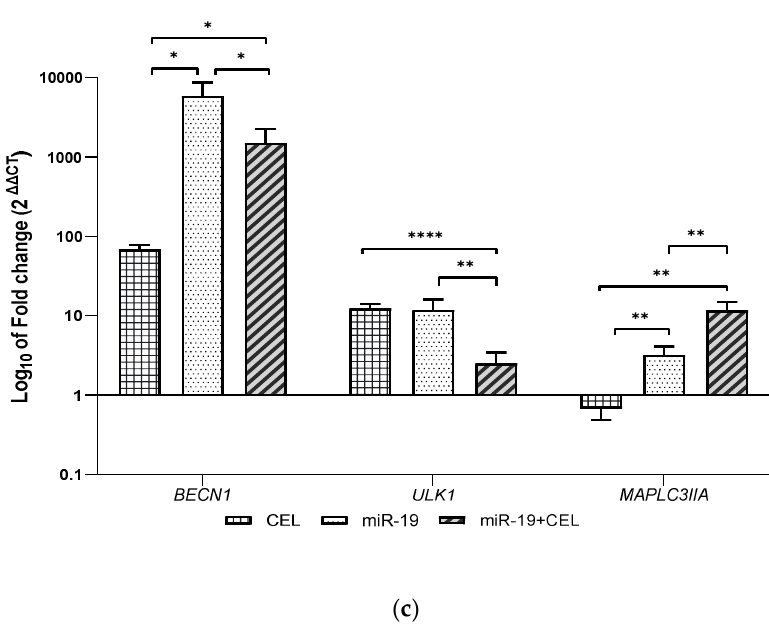
Figure 5. The RT-qPCR analysis for the genes related to autophagy after 24 h of treatment with 1 µ M celastrol, 0.25 nM miR-9-2, miR-17, miR-19 specific siRNA (miR-9-2, miR-17, miR-19) and the combination of celastrol with the knockdown of the miR-9-2 , miR-17 and miR-19 genes (miR9-2 + CEL, miR-17 + CEL and miR-19 + CEL) is presented as the fold change (2 −∆∆CT ) in the level of their expression, which was normalized to the TBP reference gene. C (control) untreated cells. The data are expressed as the mean ± SD ( n = 6 independent assays); statistically significant * p < 0.05, ** p < 0.01, *** p < 0.001, **** p < 0.0001, ordinary one-way ANOVA followed by a Tukey’s post-hoc test. ( a ) The U251MG cells that had been exposed to celastrol (1 µ M; CEL) for 24 h, the siRNA that is specific for miR-9-2 (0.25 nM; miR-9-2) for 48 h or a combination of the siRNA that is specific for miR-9-2 (0.25 nM) for 48 h and celastrol (1 µ M) for 24 h (miR-9-2 + CEL). ( b ) The U251MG cells that had been exposed to celastrol (1 µ M; CEL) for 24 h, the siRNA that is specific for miR-17 (0.25 nM; miR-17) for 48 h or a combination of the siRNA that is specific for miR-17 (0.25 nM) for 48 h and celastrol (1 µ M) for 24 h (miR-17 + CEL). ( c ) The U251MG cells that had been exposed to celastrol (1 µ M; CEL) for 24 h, the siRNA that is specific for miR-19 (0.25 nM; miR-19) for 48 h or a combination of the siRNA that is specific for miR-19 (0.25 nM) for 48 h and celastrol (1 µ M) for 24 h (miR-19 +